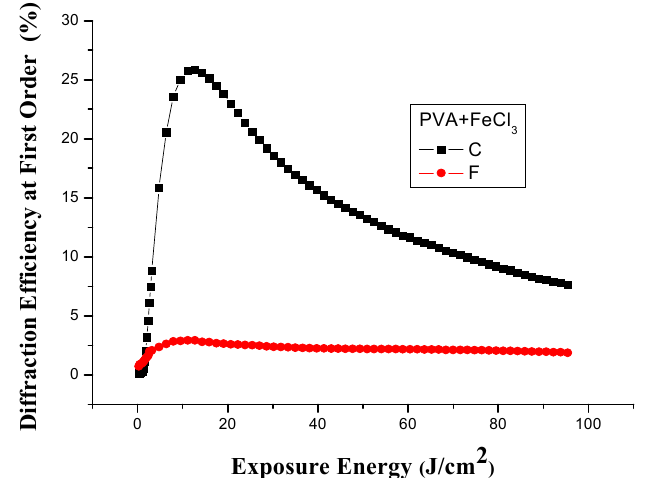
Figure 5. Diffraction intensity versus energy for samples C (PVA:FeCl F (PVA:FeCl ratio of 3